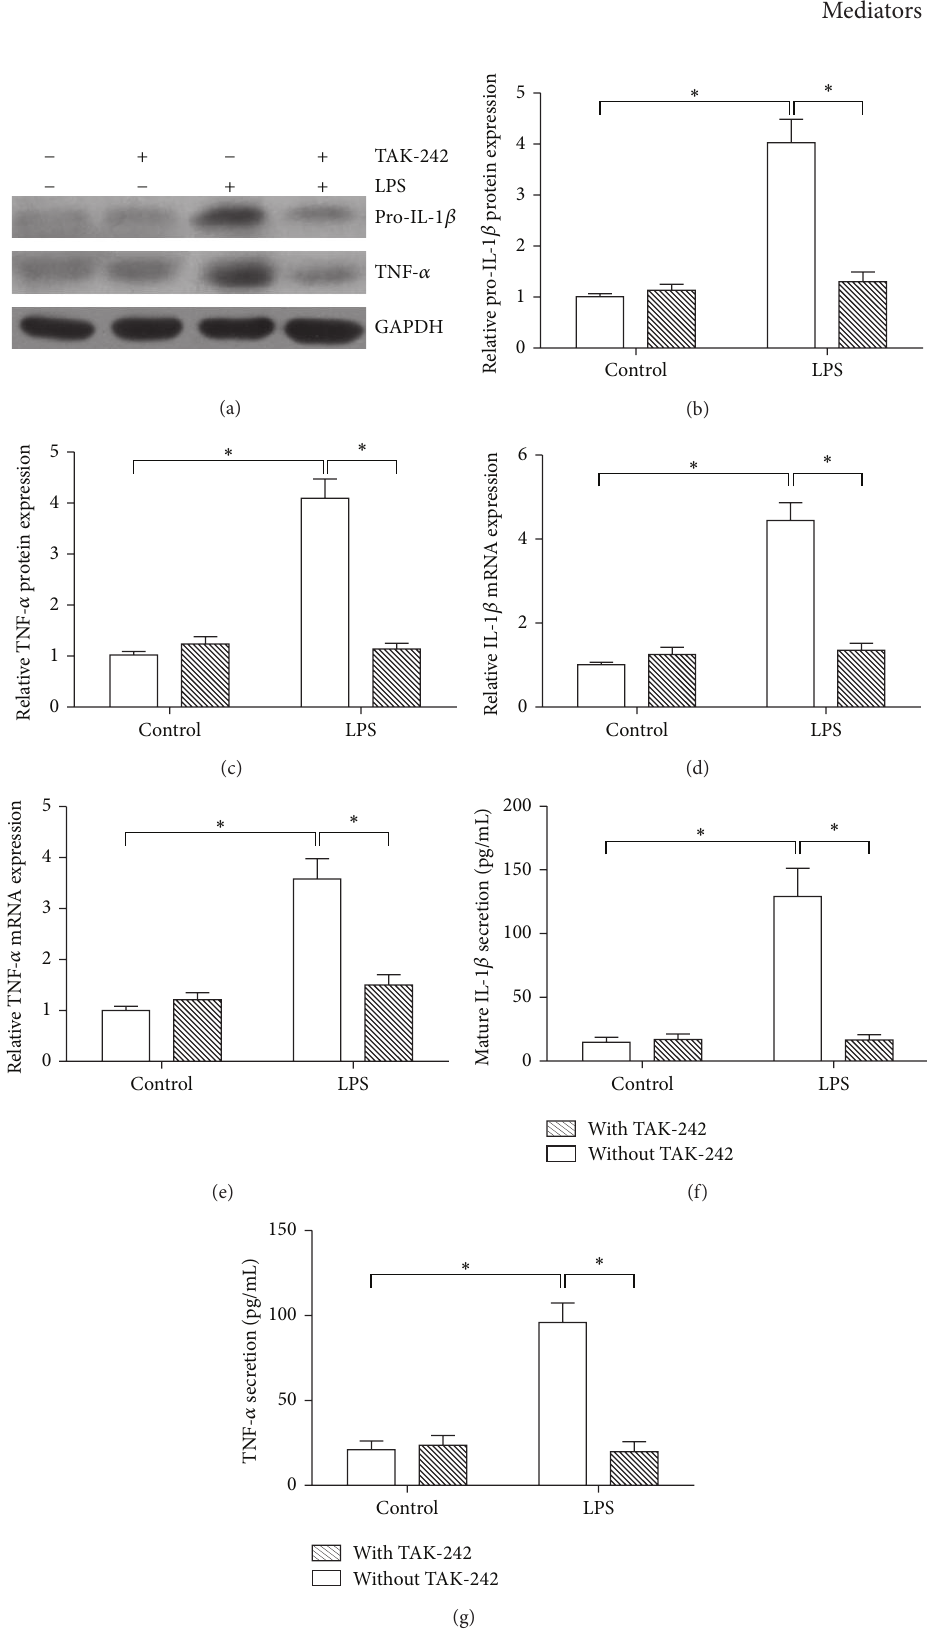
Figure 5: Effect of TLR4 on the expression of IL-1 𝛽 and TNF- 𝛼 in SFs. SFs were pre-treatment with or without TAK-242, then stimulated with LPS. Cell lysates were collected (at 12 h) for analyzing the protein expression by Western blot (a), and the relative expression of pro-IL-1 𝛽 (b) and TNF- 𝛼 (c) was calculated. Total RNAs were extracted (at 6 h) for detecting mRNAs of IL-1 𝛽 (d) and TNF- 𝛼 (e) by real-time quantitative PCR. The cell-free culture medium from each sample was collected at 12 h, and the mature IL-1 𝛽 (f) and TNF- 𝛼 (g) proteins secreted into the cell culture media were measured by ELISA. Data shows all the values from independent samples of 𝑛 = 3 , ∗ 𝑃 < 0.05 versus nonstimulated controls or cells without TAK-242